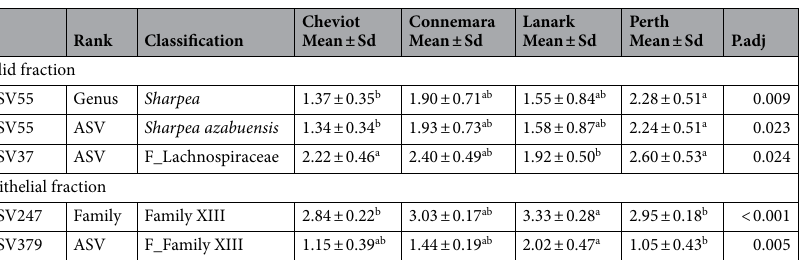
Table 4. Differential abundance analysis investigating the effect of breed on the abundance bacterial and archaeal taxa in solid, liquid and epithelial ruminal fractions. Analysis was conducted across all taxonomic ranks for bacterial populations (Phylum, Class, Order, Family, Genus and ASV), and lower taxonomic ranks for archaeal populations (Genus and ASV) using the LRT and Wald’s test from DESeq2. Table reports significant findings along with the log10 of normalised counts (Mean ± Sd), BH adjusted P values, pairwise comparisons (superscripts), taxonomic rank and classification. Solid (Cheviot n = 8, Connemara n = 5, Lanark n = 9, Perth n = 7), liquid (Cheviot n = 9, Connemara n = 5, Lanark n = 9, Perth n = 5), epithelial (Cheviot n = 9, Connemara n = 3, Lanark n = 6, Perth n =